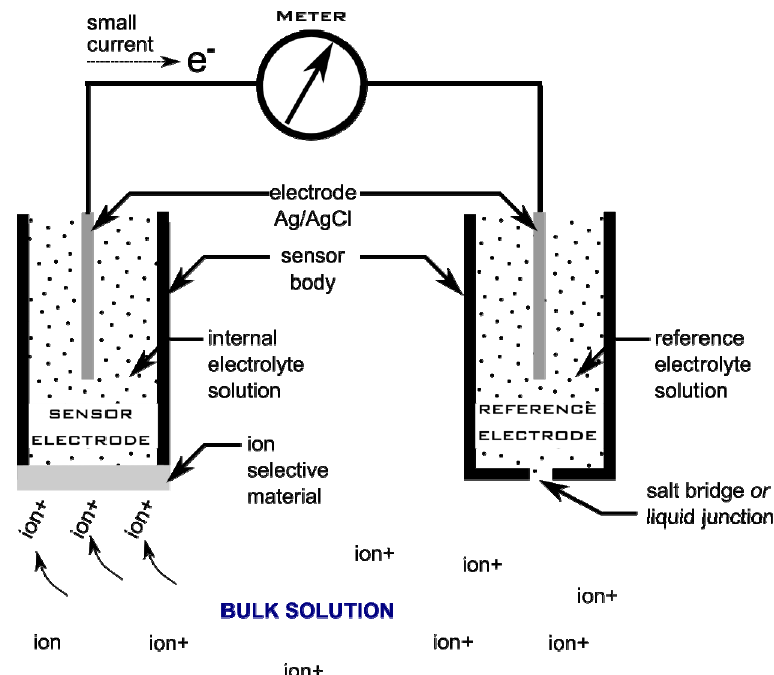
Figure 6. Illustration of the standard components of an ISE system used for activity measurements in